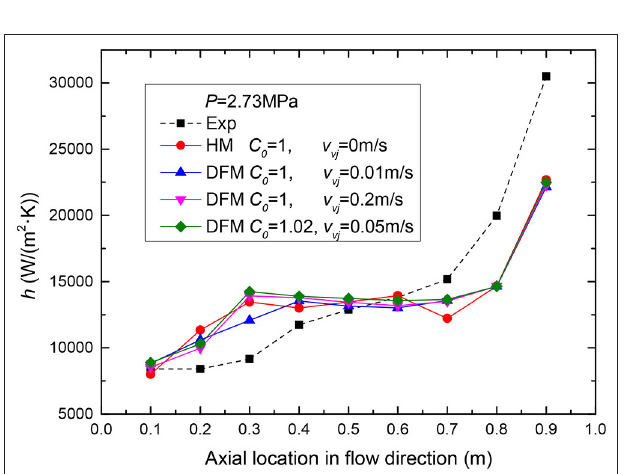
FIGURE 9 | The comparisons between experimental and numerical heat transfer coefficients for q = 294.91 kW/m 2 and G = 500 kg/(m 2 ·